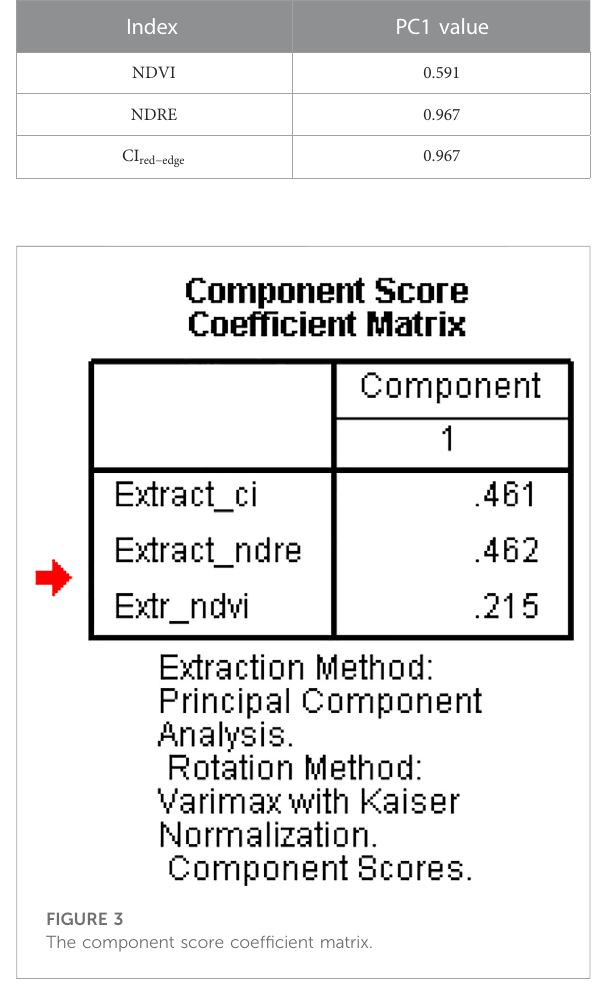
FIGURE 3 The component score coef fi cient